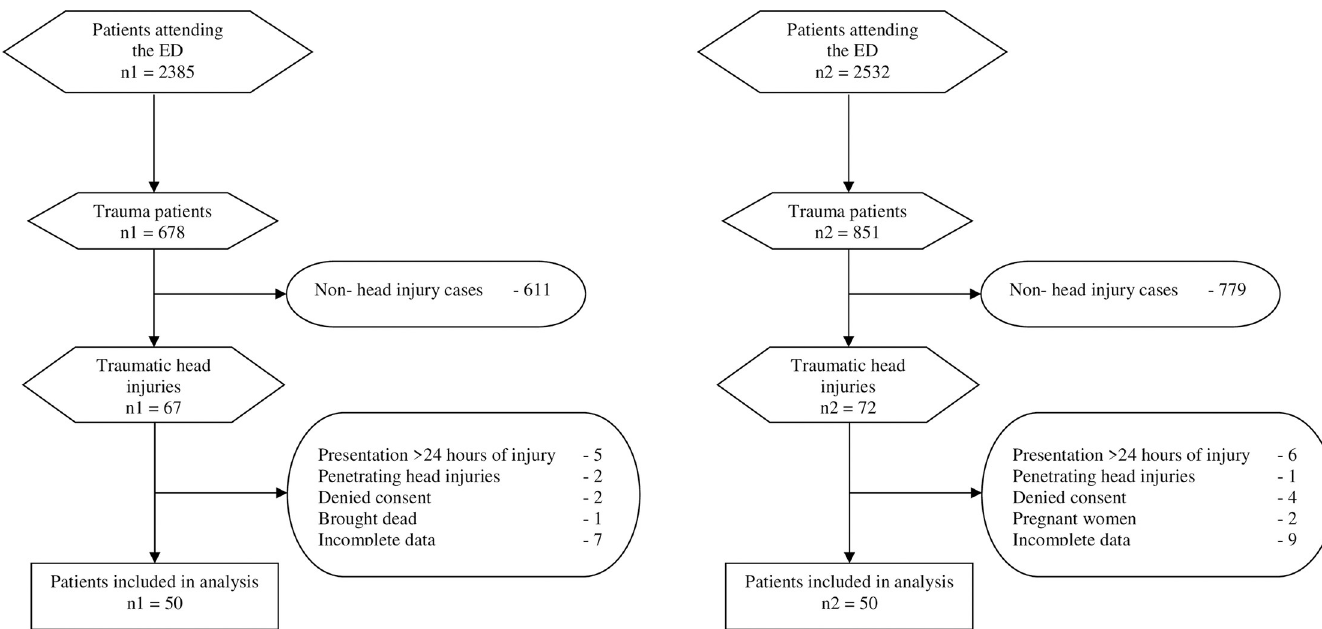
Fig 1. Standards for Reporting Diagnostic Accuracy studies (STARD) [15] flow diagrams for patients who presented with THI in pre and post-implementation periods respectively.